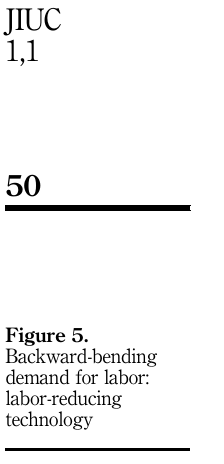
shape as wages in Figure 4, but this time, the time variable is drawn on the vertical axis. In Figure 5, the demand for labor starts at an initial level of 28.66 man-hours, as before under the initial technology A. However, the labor demand starts backward-bending after it reaches a level of 42.1 man-hours. At the end, the demand for labor is as low as 0.552 man-hours: P6. Under the labor-reducing technology, the demand for labor increases first but starts